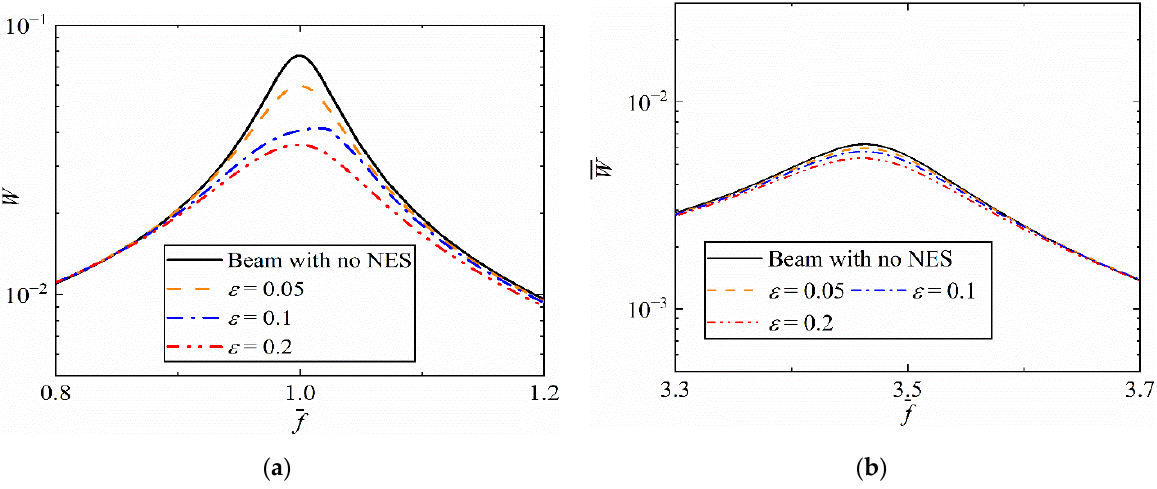
Figure 5. ( a ) Response at the first resonance frequency under varying mass ratio; ( b ) response at the second resonance frequency under varying mass